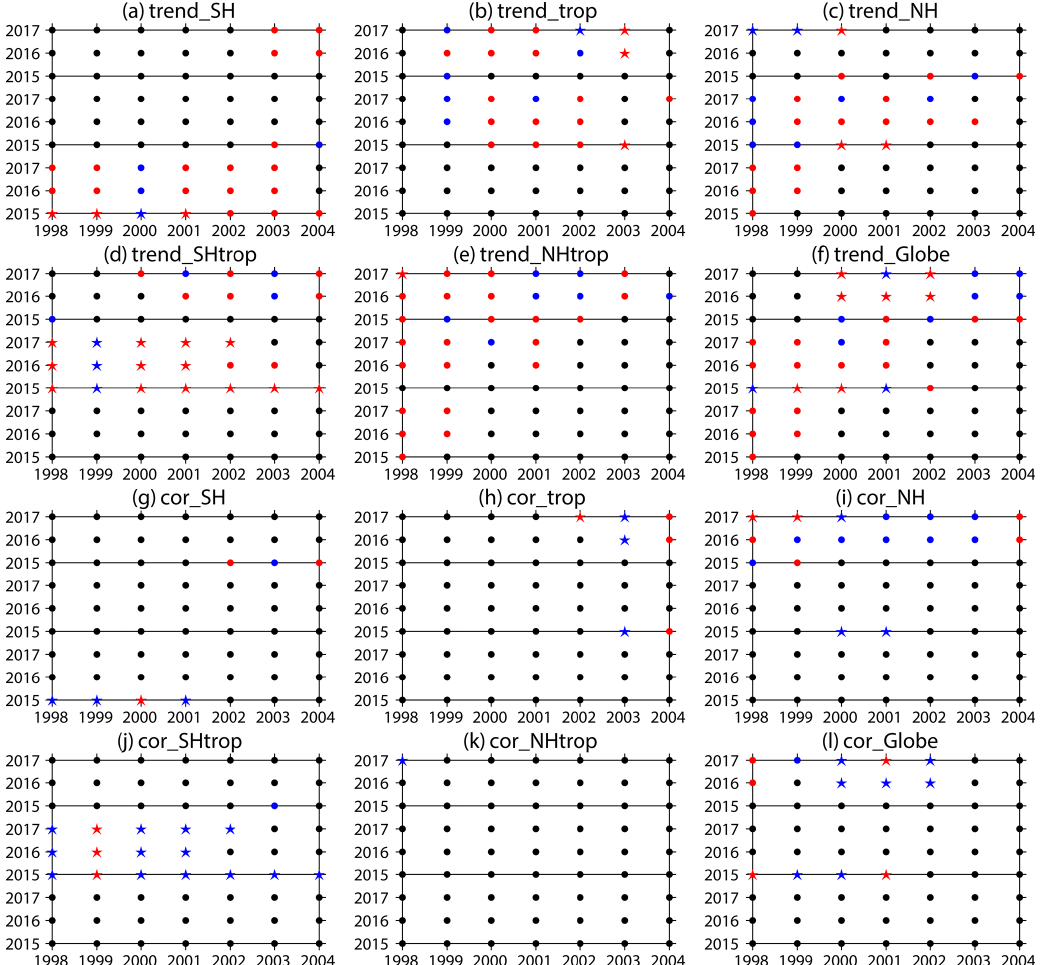
Figure 9. Trend significance of the first three SST principal components (PCs) in (a) the extratropical Southern Hemisphere (SH; 70–20 ◦ S), (b) the tropics (TROP; 20 ◦ S–20 ◦ N), (c) the extratropical Northern Hemisphere (NH; 20–70 ◦ N), (d) the extratropical Southern Hemisphere and the tropics (SHtrop; 70 ◦ S–20 ◦ N), (e) the extratropical Northern Hemisphere and the tropics (NHtrop; 20 ◦ S–70 ◦ N), (f) the globe (70 ◦ S–70 ◦ N), and the corresponding (g, h, i, j, k, l) correlation significances between them and the vertical E–P flux (Fz; area weighted from 100 to 30hPa over 70–50 ◦ S) during different beginning years ( x axes) and ending years ( y axes). The red and blue dots indicate that a positive and negative trend or correlation coefficient are significant, respectively. The black dots indicate that the trends or correlation coefficients are not significant. The stars indicate that the trends and the corresponding correlation coefficients are both significant. Each panel is divided into three regions, from bottom to top, corresponding to the first, second, and third PCs, respectively. The criterion to distinguish whether the trends and correlations are significant or not is the 90% confidence